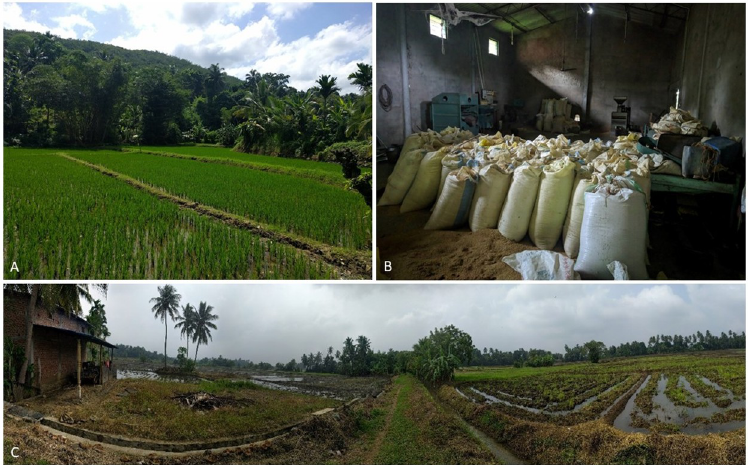
Fig 2. Typical smallholder rice growing environment in Sri Lanka. A. Smallholder rice field embedded in a matrix of surrounding tropical forest. B. Storage facility structure with harvested rice in white storage bags. C. Farmers house and surrounding paddy